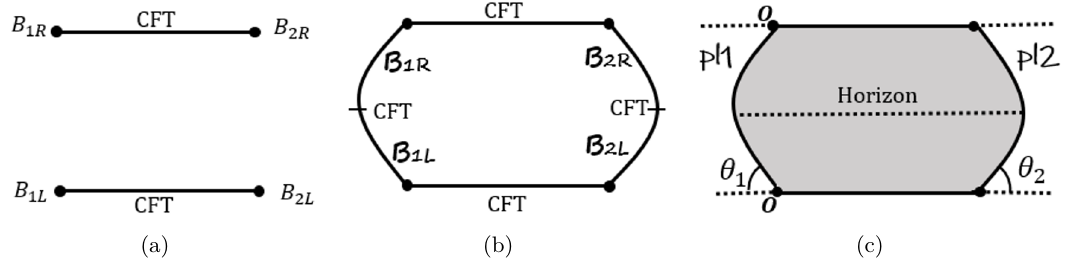
Figure 1 . (a): boundary perspective. The ( d − 1) -dimensional quantum systems B 1 L , B 1 R and B 2 L , B 2 R are in equilibrium with two d -dimensional finite-sized baths. (b): brane perspective. Two d -dimensional eternal black holes are in equilibrium with two d -dimensional finite-sized baths. (c): bulk gravity perspective. The Planck branes are back-reacted to the ambient